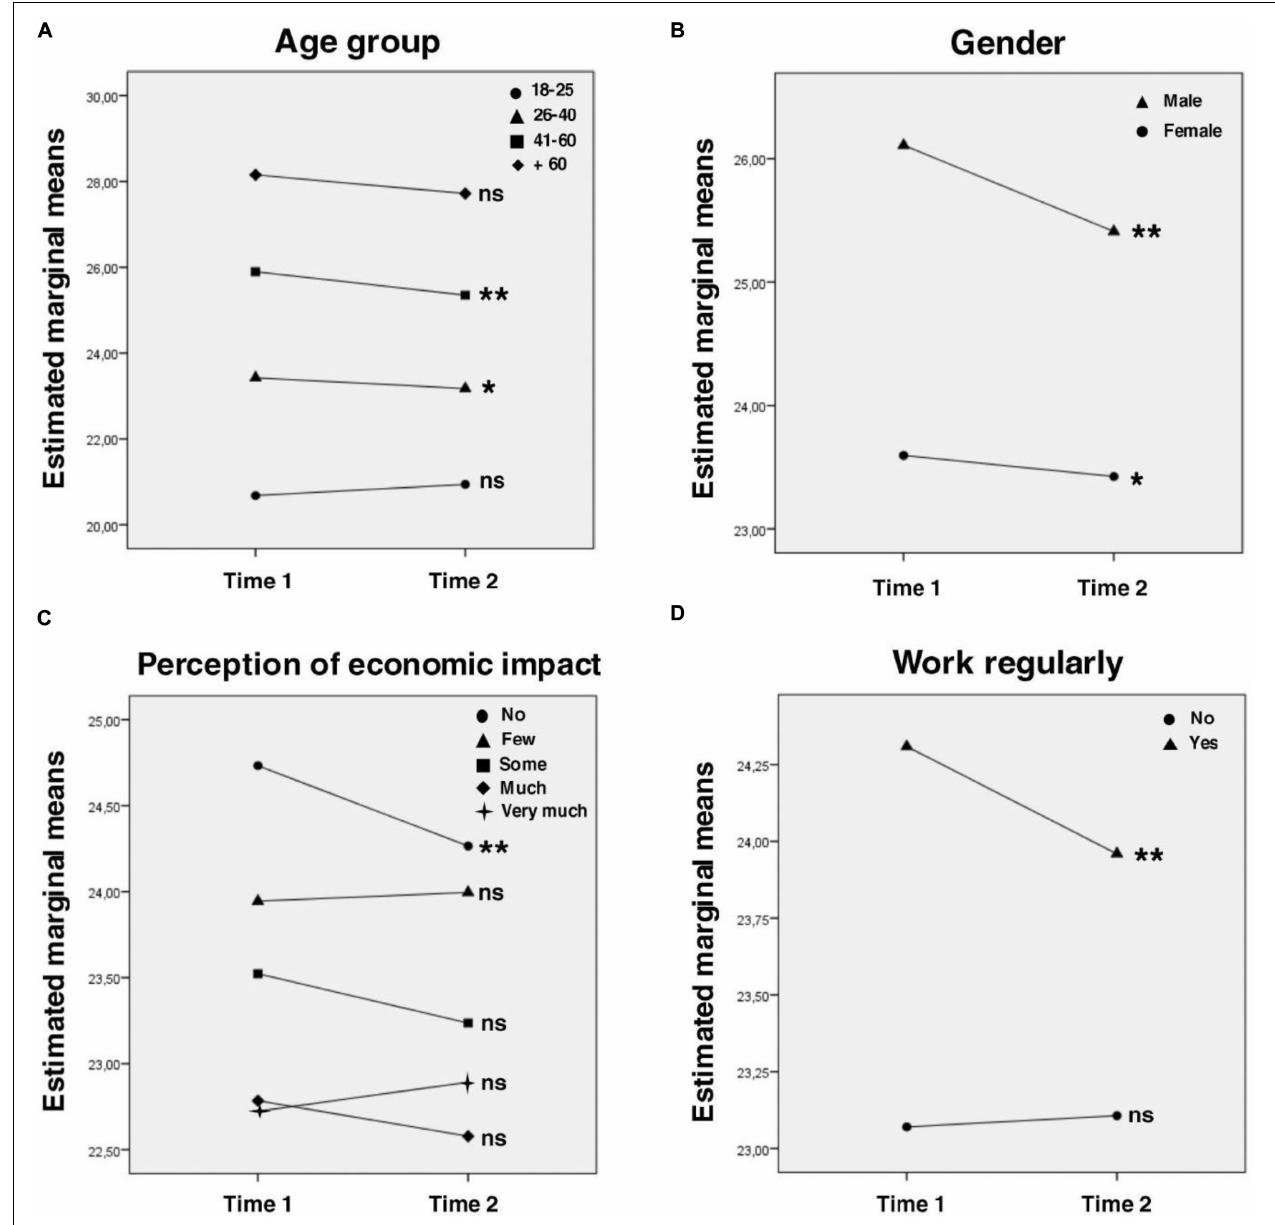
FIGURE 3 | Interaction effects for positive affect. Intragroup analysis with Bonferroni correction are expressed in the graphs: line-group with * showed p < 0.05 intragroup differences between time 1 and time 2; line-group with ** showed p < 0.01 intragroup differences between time 1 and time 2; line-group with ns showed no statistical intragroup differences between time 1 and time 2. Post hoc intergroup comparisons with Bonferroni correction (only significant differences are considered, all the comparisons missing were not statistically significant; * p < 0.05, ** p < 0.01): (A) All the intergroup comparisons were statistically significant**. (B) All the intergroup comparisons were statistically significant**. (C) Time 1: no, few*; no, some**; no, much**; no, very much**; few, very much**. Time 2: no, some**; no, much**; no, very much**; few, much*; few, very much*. (D) All the intergroup comparisons were statistically